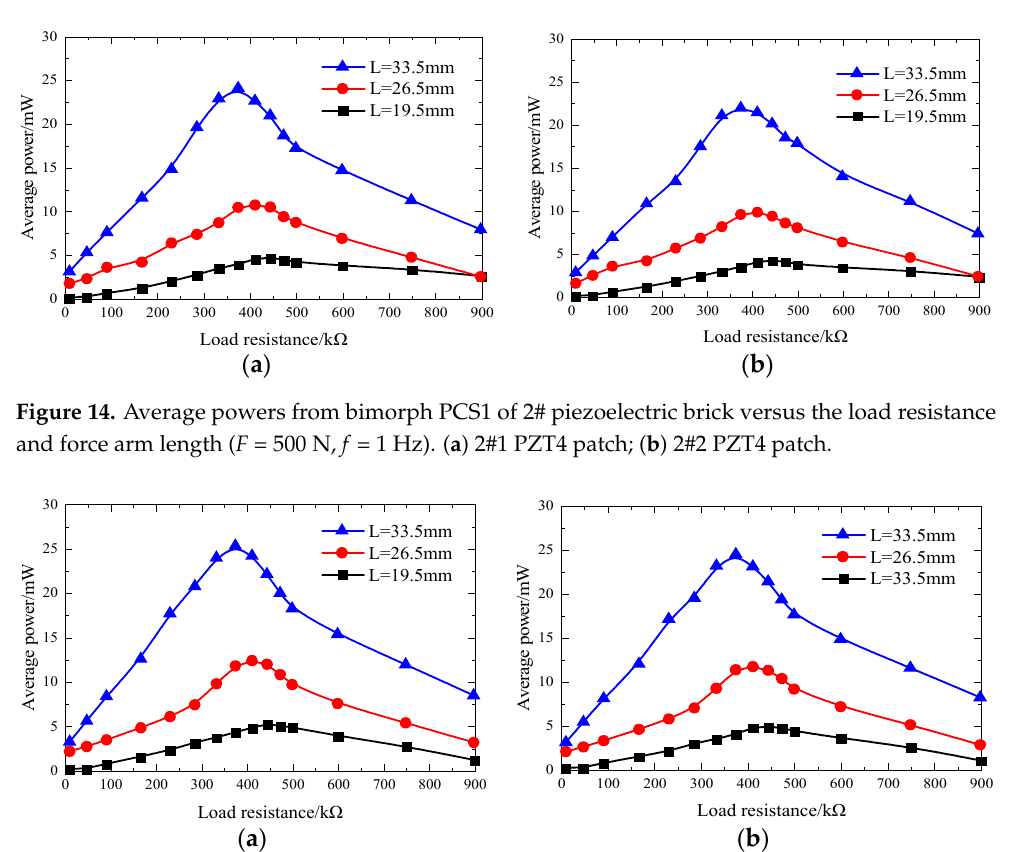
Figure 15. Average powers from bimorph PCS2 of 2# piezoelectric brick versus the load resistance and force arm length ( F = 500 N, f = 1 Hz). ( a ) 2#3 PZT4 patch; ( b ) 2#4 PZT4 patch.